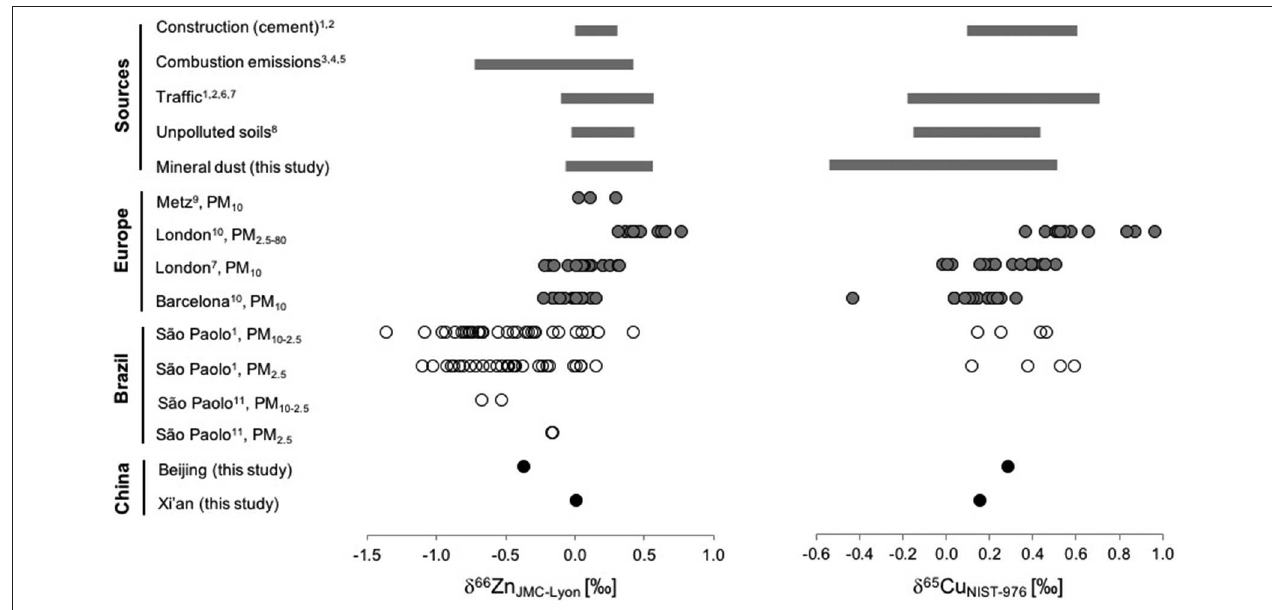
FIGURE 7 | Comparison of measured isotope ratios of Zn (left panel, expressed as δ 66 Zn JMC − Lyon ) and Cu (right panel, expressed as δ 65 Cu NIST − 976 ) in urban aerosols from Europe (gray circles), Brazil (open circles), and China (filled circles). Additionally, ranges of the most important aerosol sources are given. (References: 1. Souto-Oliveira et al., 2018, 2. Souto-Oliveira et al., 2019, 3. Mattielli et al., 2009, 4. Shiel et al., 2010, 5. Gelly et al., 2019, 6. Thapalia et al., 2010, 7. Dong et al., 2017, 8. Fekiacova et al., 2015, 9. Cloquet et al., 2006, 10. Ochoa Gonzalez et al., 2016, 11. Gioia et al.,